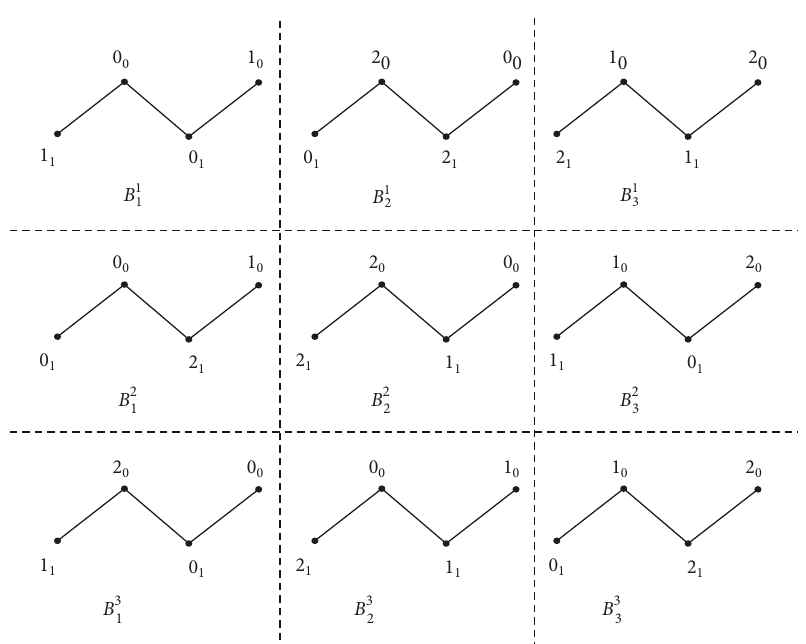
Figure 8: 3 mutually orthogonal covers of K